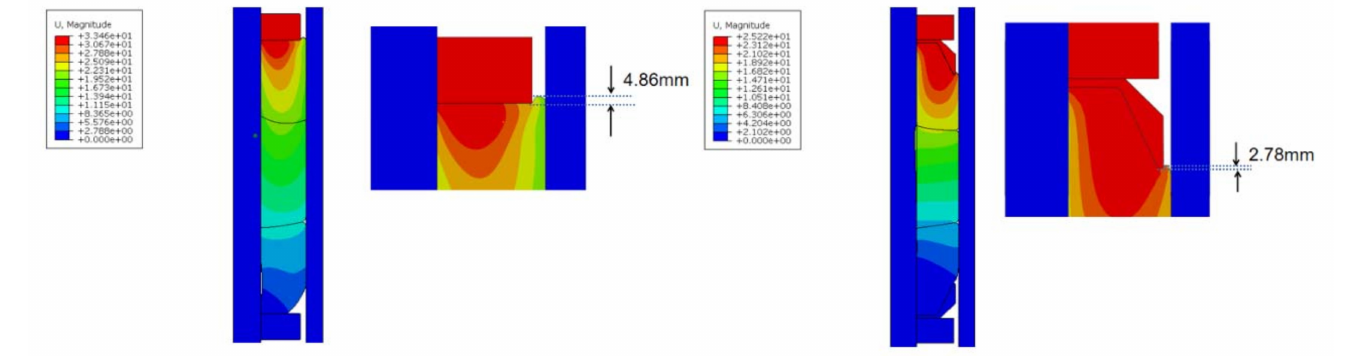
Figure 4. Upwarping of rubber packing element end at 60 KN ( left picture without guard ring, right picture with guard